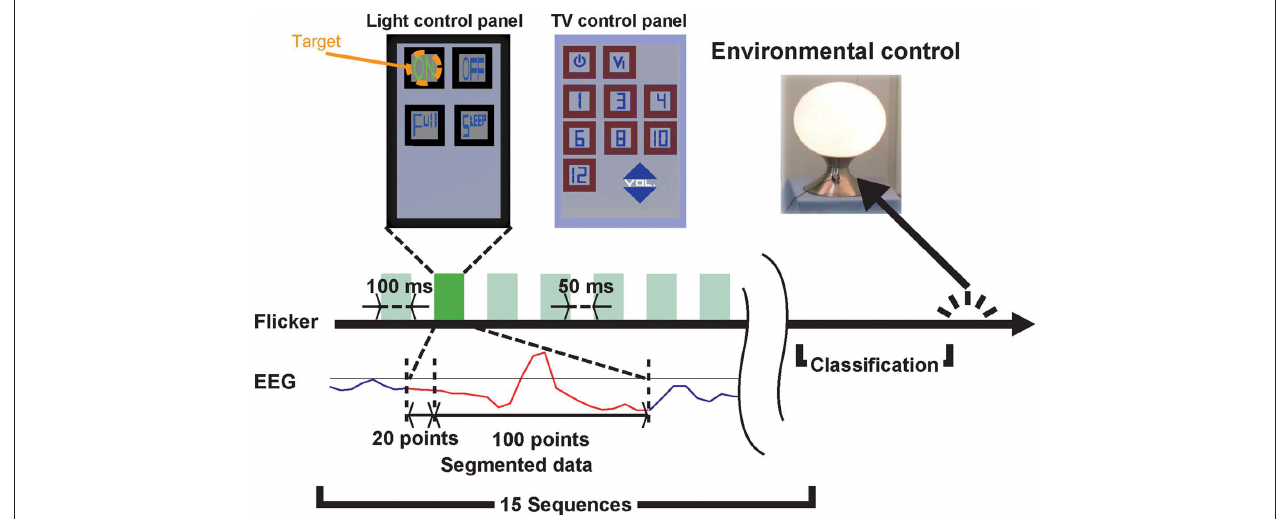
FIgure 2 | experimental procedure. The icons change color from blue to green at the time of intensification, and the elicited ERPs are recorded. The red solid line in the EEG data indicates the segmented portion used for classification. The target was classified by Fisher’s linear discriminant analysis after 15 sequences. The light control panel had four icons (turn on, turn off, light up, and dim), whereas the TV control panel had 11 icons (turn on, change channel, change video mode, volume up, and volume